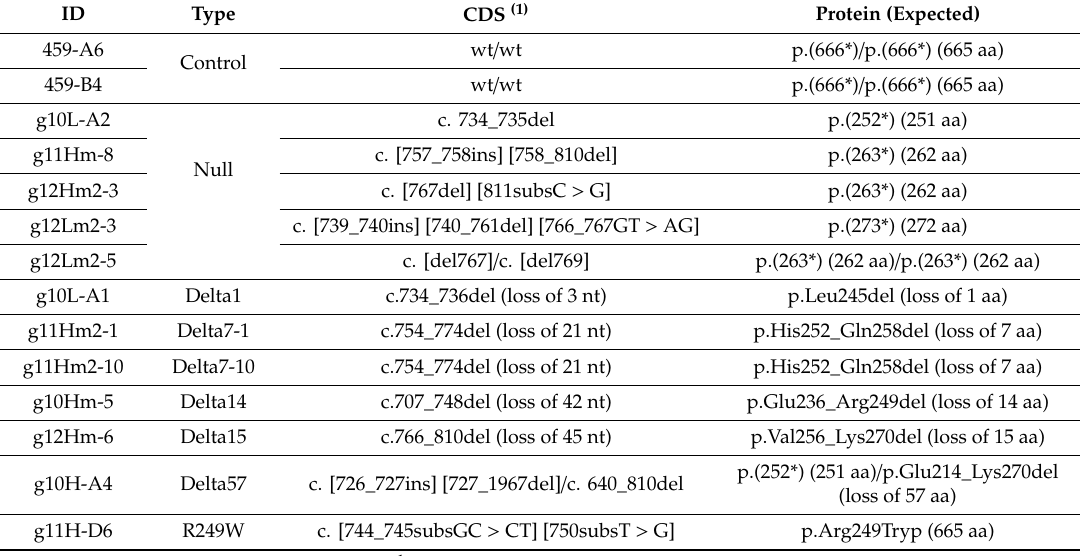
Table 3. Molecular properties of the selected